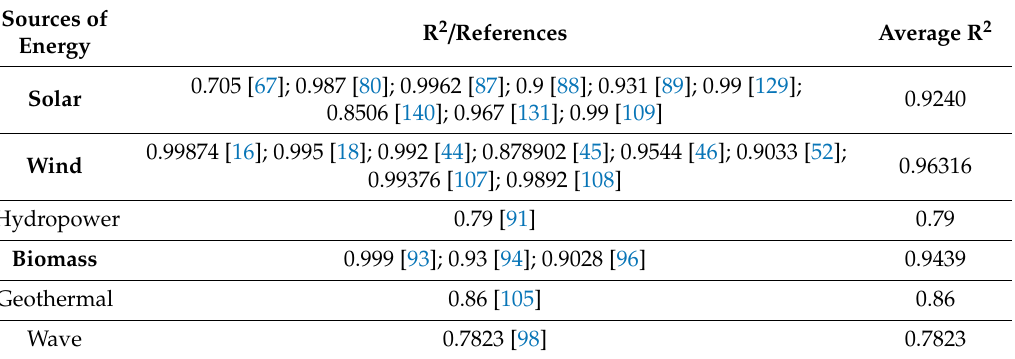
Table 8. R 2 values in the energy prediction literature.